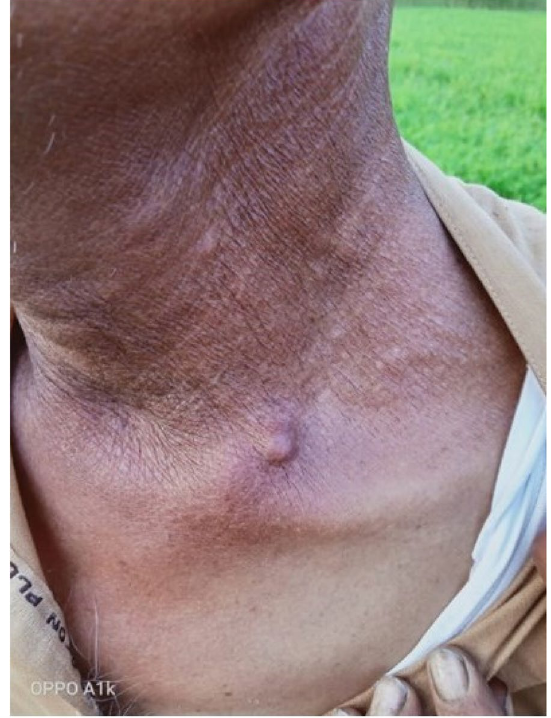
Fig. 5 Clinical picture of a metastatic skin